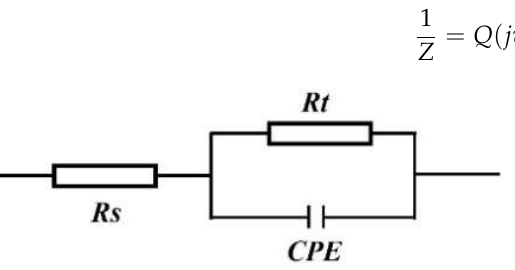
Figure 11. Equivalent circuit diagram based on the EIS results. Table 2. Electrochemical impedance spectroscopy fitting parameters. Condition